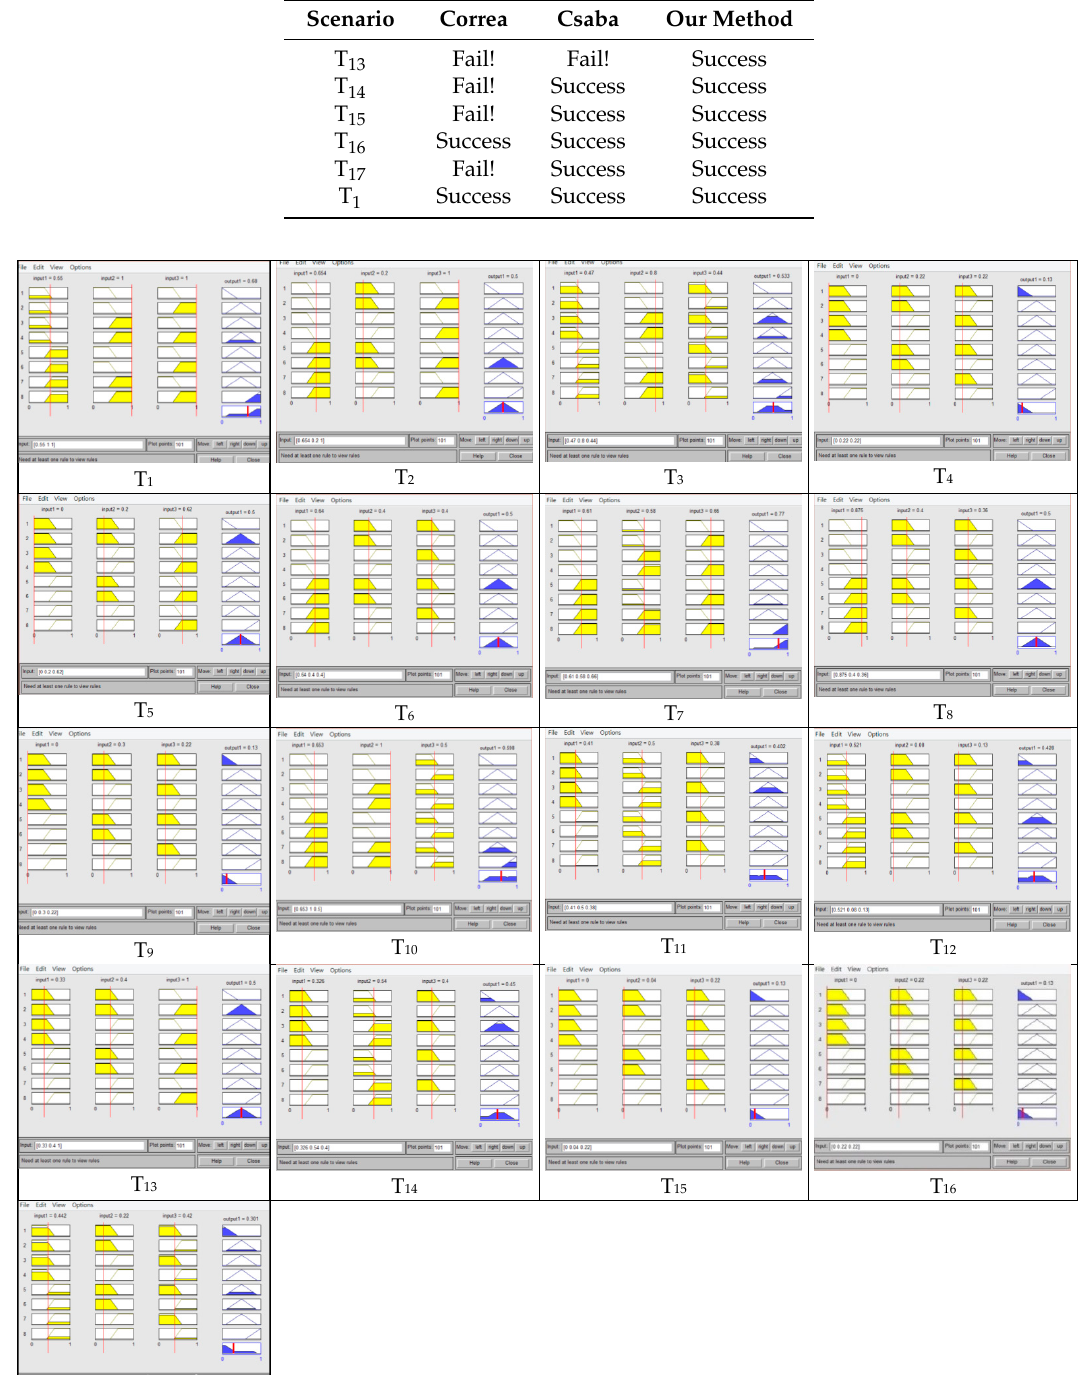
Figure 18. Fuzzy inputs and decisions for combining sensor maps at T 1 –T 17 .